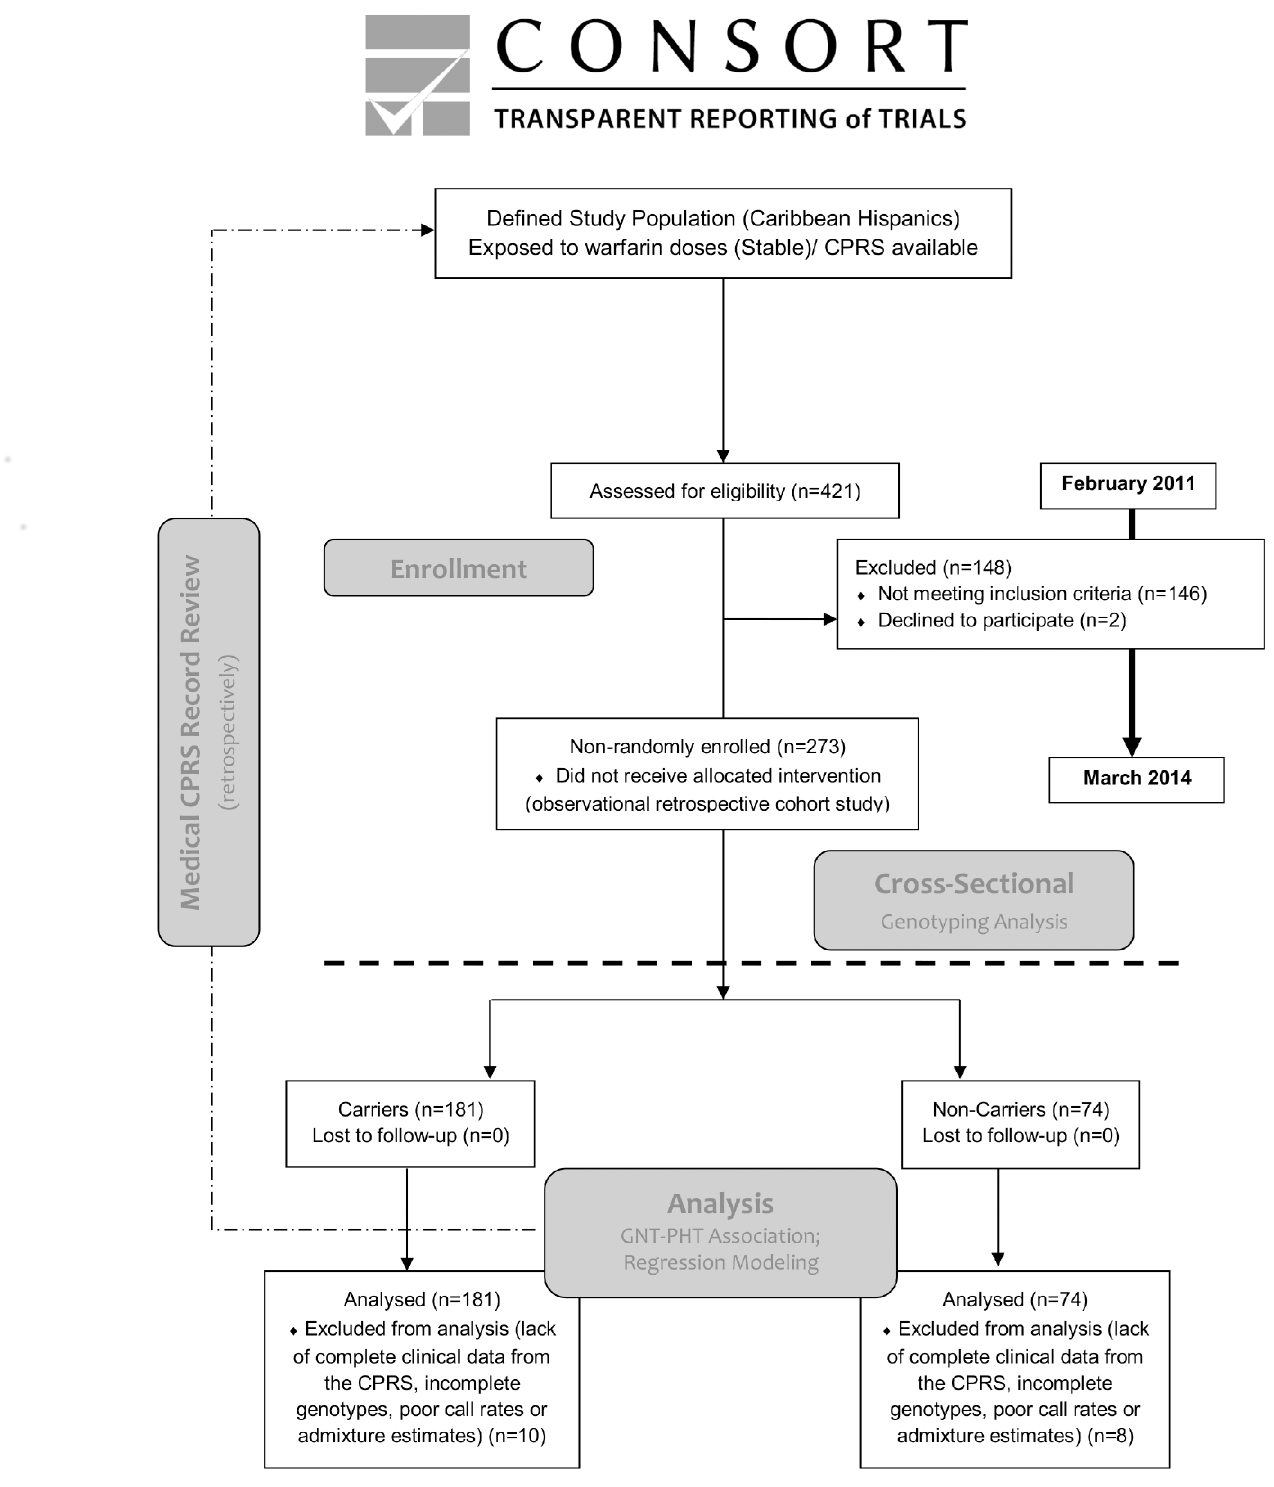
Fig 1. CONSORT flowchart illustrating an open-label, single-center, population-based, observational, retrospective cohorts study with cross- sectional genotyping analysis. The study uses existing data collected in the past (CPRS) to preliminarily identify eligible participants from the defined study population (i.e., Caribbean Hispanics), determine their stabilization status and retrieve relevant covariates for performing regression analysis and association testing. GNT stands for genotypes. PHT stands for phenotypes (e.g., therapeutic warfarin dose). CPRS stands for computerized patient record system.